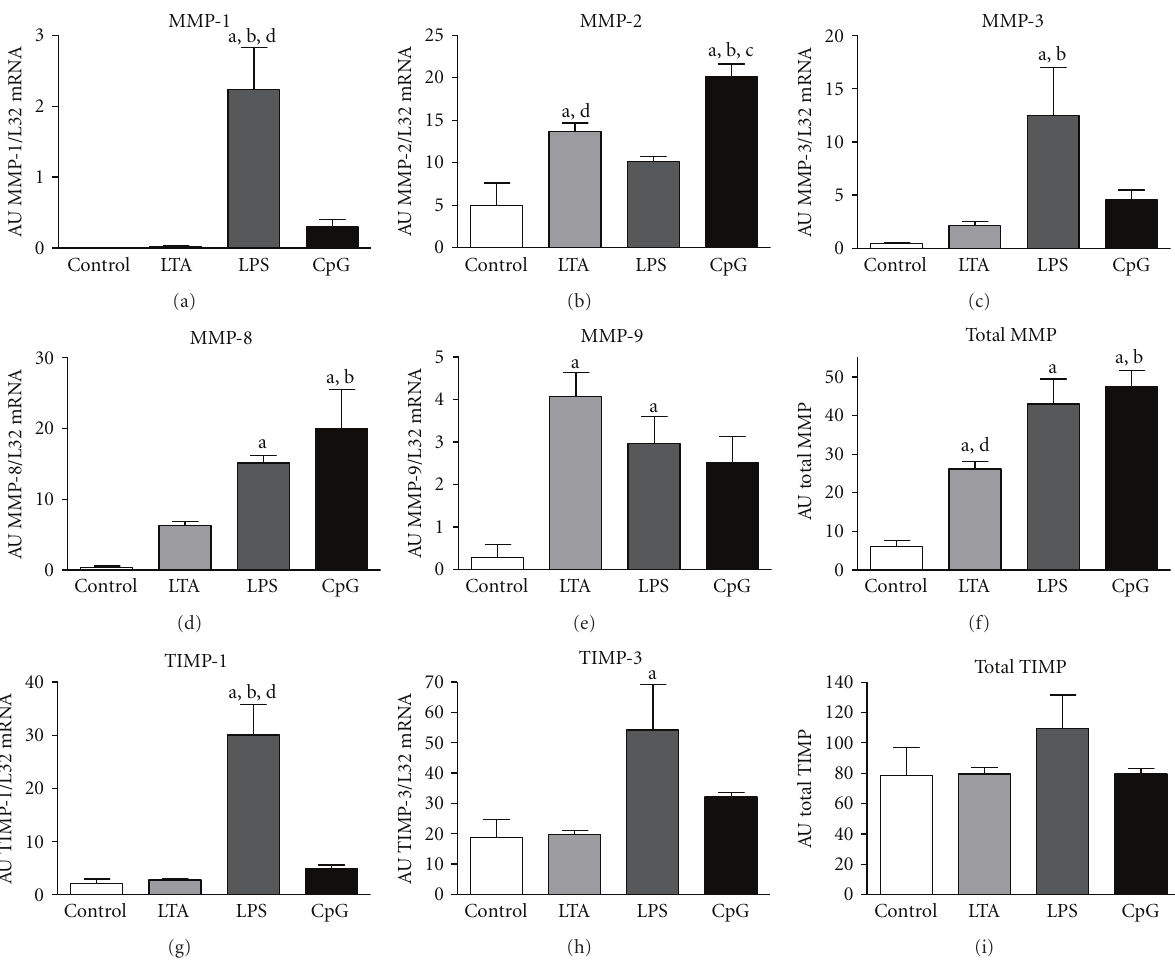
Figure 6: MMP, TIMP mRNA expression. Densitometric analysis of MMP-1, -2, -3, -8, 9, TIMP-1, and -3 in control, LTA-, LPS-, and CpG- ODN-stimulated pulmonary tissue as well as total MMP and TIMP expression. Values of mRNA expressions are normalized to L32 and expressed as arbitrary units (AU). Alphabetic characters indicate P -values < . 05 from Bonferroni post-hoc testing (a = versus control, b = versus LTA, c = versus LPS, d = versus CpG-ODN; M ± SEM; n =